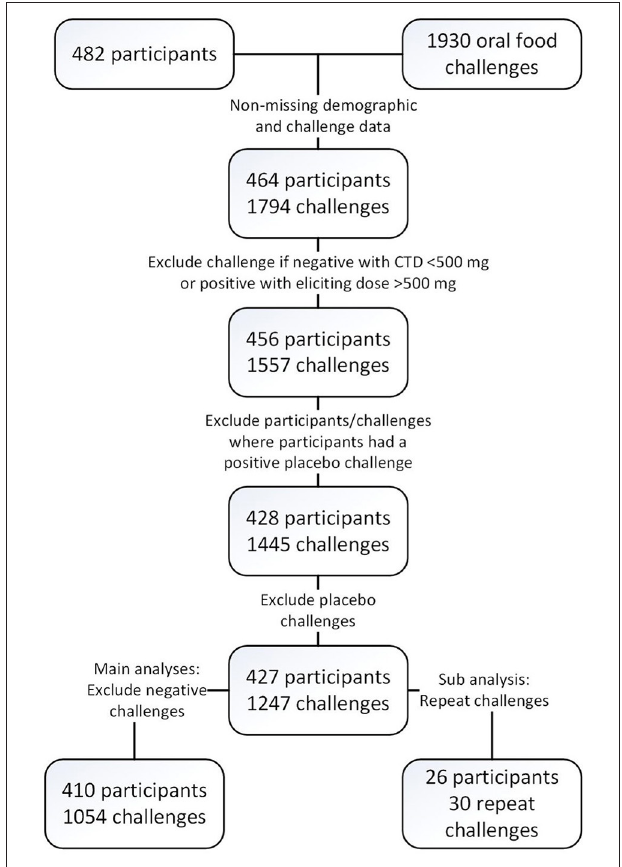
FIGURE 1 | Consort diagram.